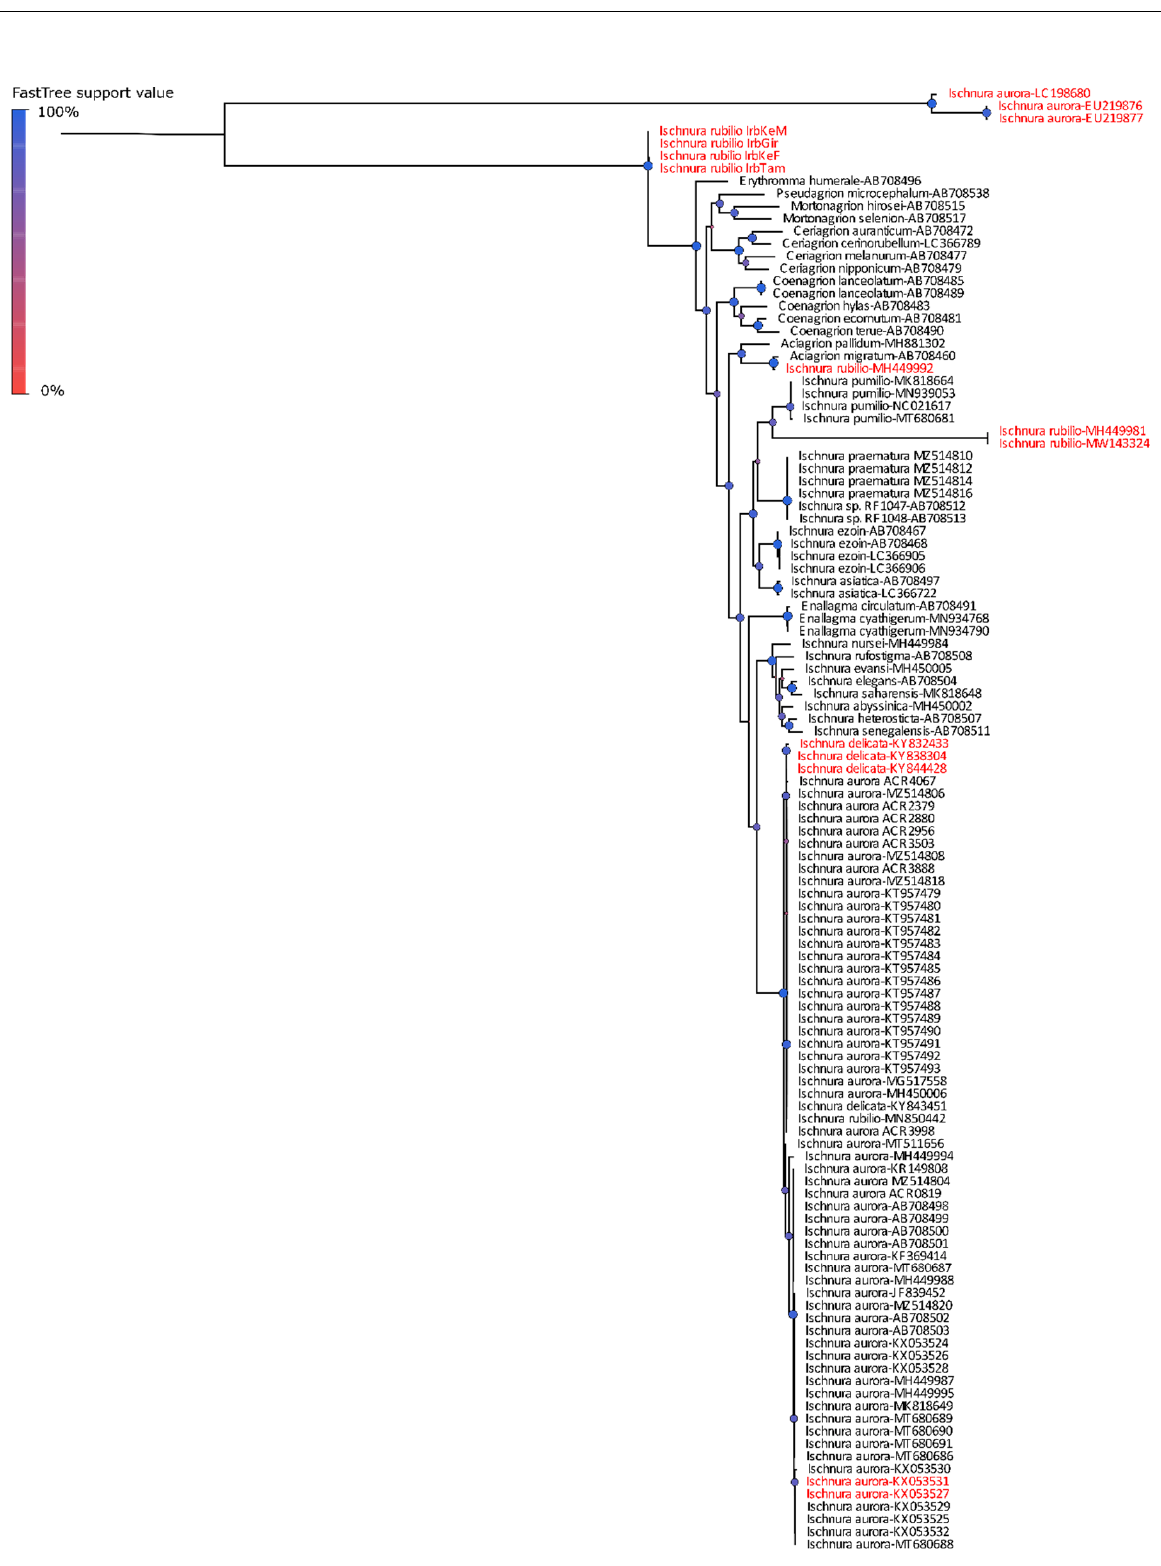
Figure A3. Maximum likelihood tree obtained with FastTree 2.1.11 for the COI dataset (117 sequences; 457 bp-long). The tree is rooted by the midpoint. Highlighted in red are the ten sequences downloaded from GenBank and the four sequences obtained in this study that were finally excluded from our dataset. The coloured dots on the nodes represent FastTree support values according to the legend on the left.